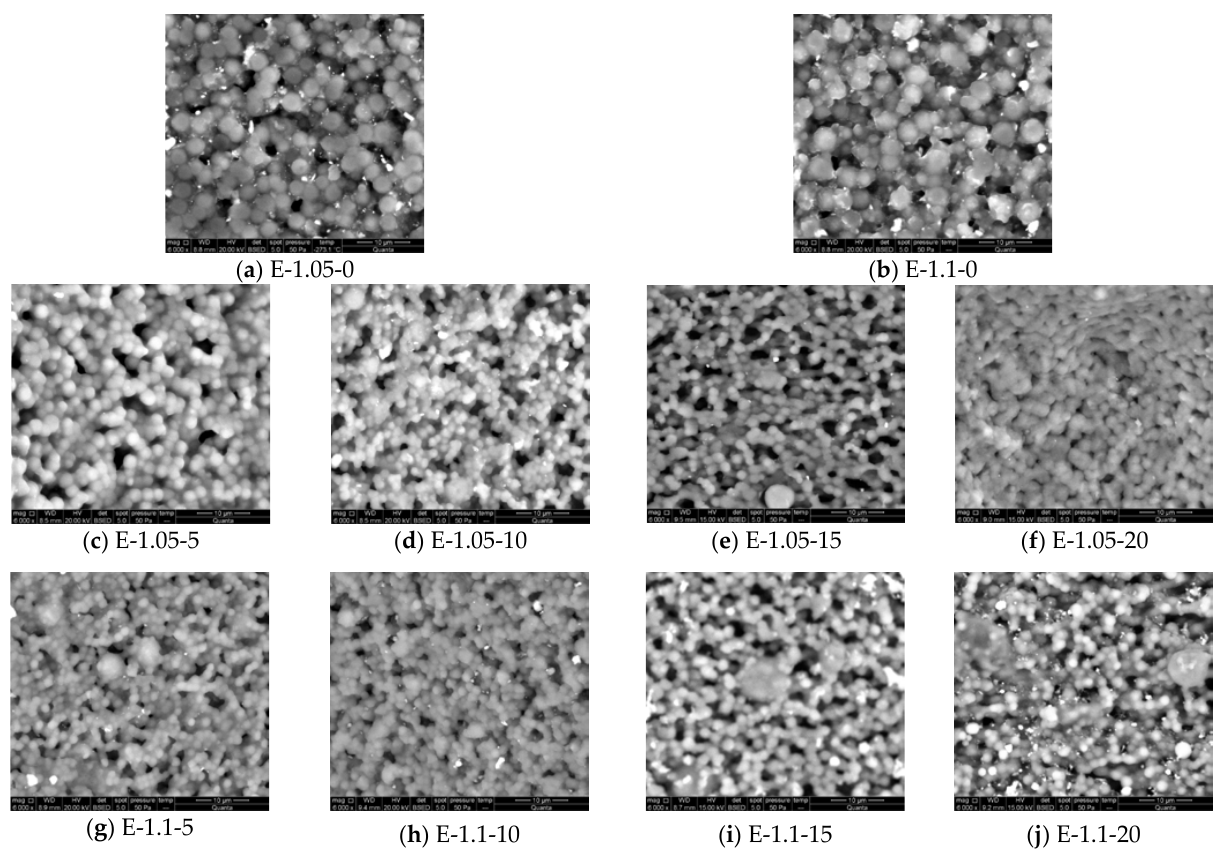
Figure 4. SEM pictures at 6000 × magnification of the synthesized elastomer matrices with different mSD-(LDPE · EVA-RT27) contents and [NCO]/[OH] values of 1.05 and 1.1.